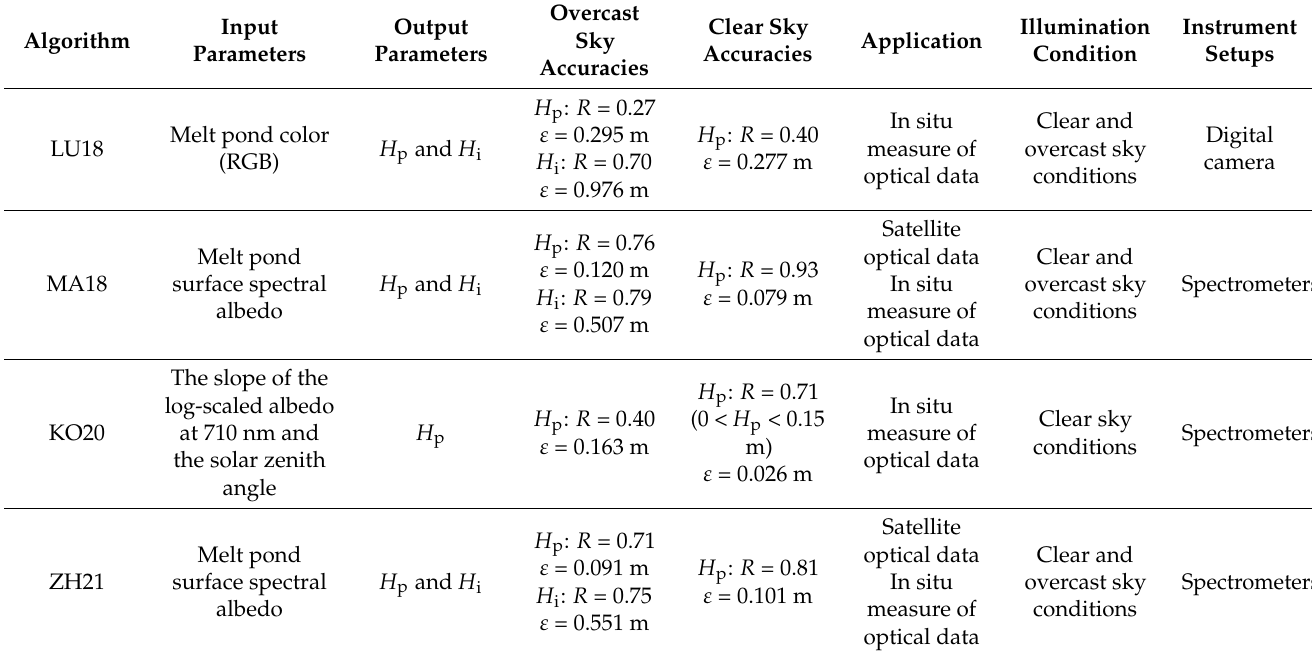
Table 2. Retrieval results and applications for the above four